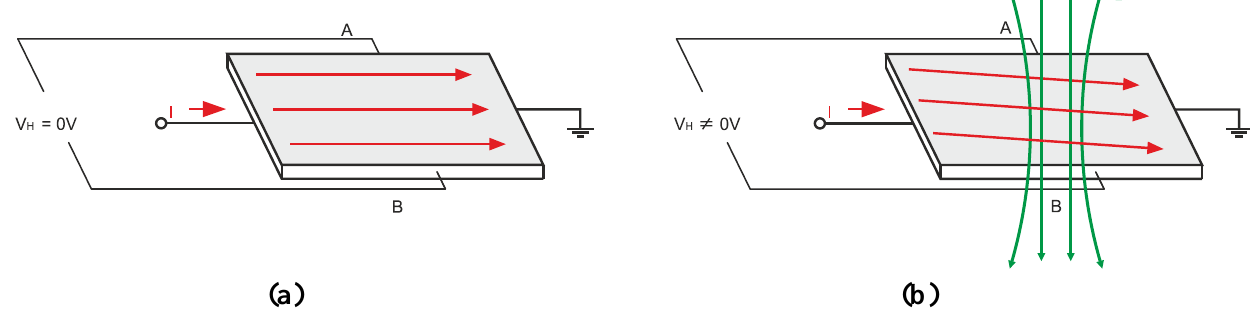
Figure 28. Hall-effect principle. (a) No magnetic field. (b) Magnetic field